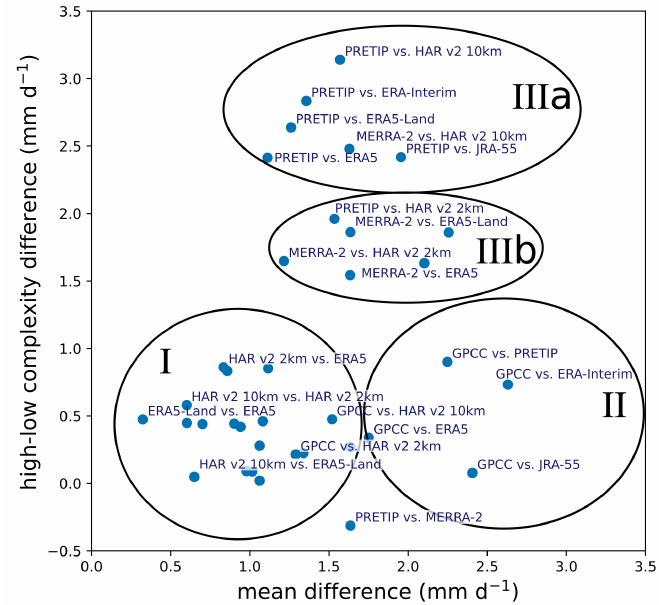
Figure 9. Visualization of precipitation differences between each two precipitation products based on the relationship between mean difference (yellow diamonds in Figure 7) and the difference between high (red dots in Figure 7) and low (blue squares in Figure 7) complexity precipitation. The groups describe: (I) low mean difference and low difference between high and low terrain complexity, (II) high mean difference but low difference with respect to terrain complexity and (III) medium overall difference but large variation depending on terrain complexity. Only some labels of all pairs as listed in Figure 7 are